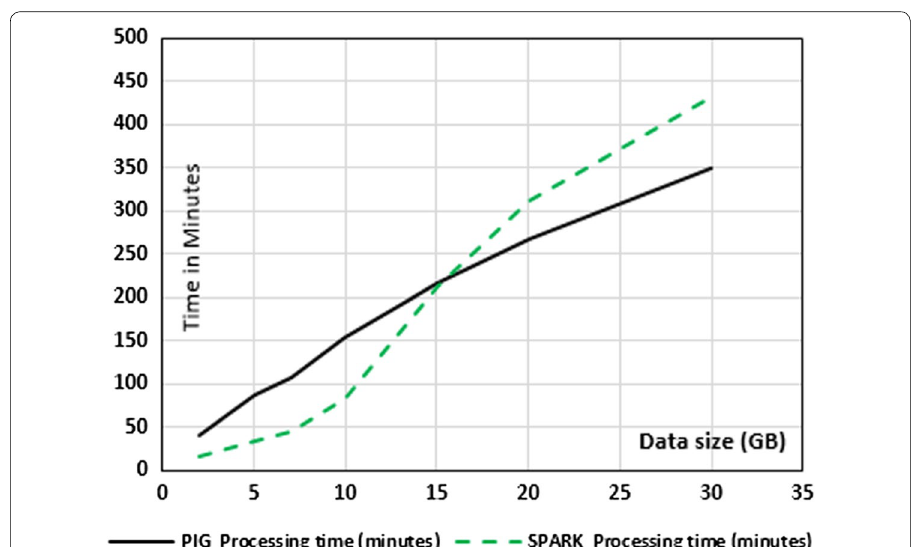
Fig. 6 Comparison in process‑time between Pig and Scala scripts with 5 workers: This is the first experiment where 5 workers and one master are used. The experiment showed a good performance for Spark, when data size is smaller than 15 GB. Pig gains better performance when data size increases dramatically in comparison with the available memory